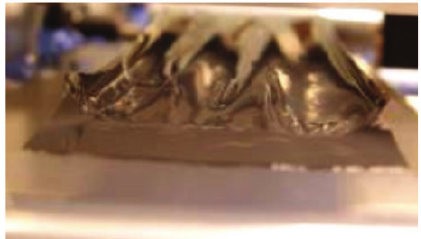
Figure 1: Nafion membrane exhibiting distortion upon contact with liquid